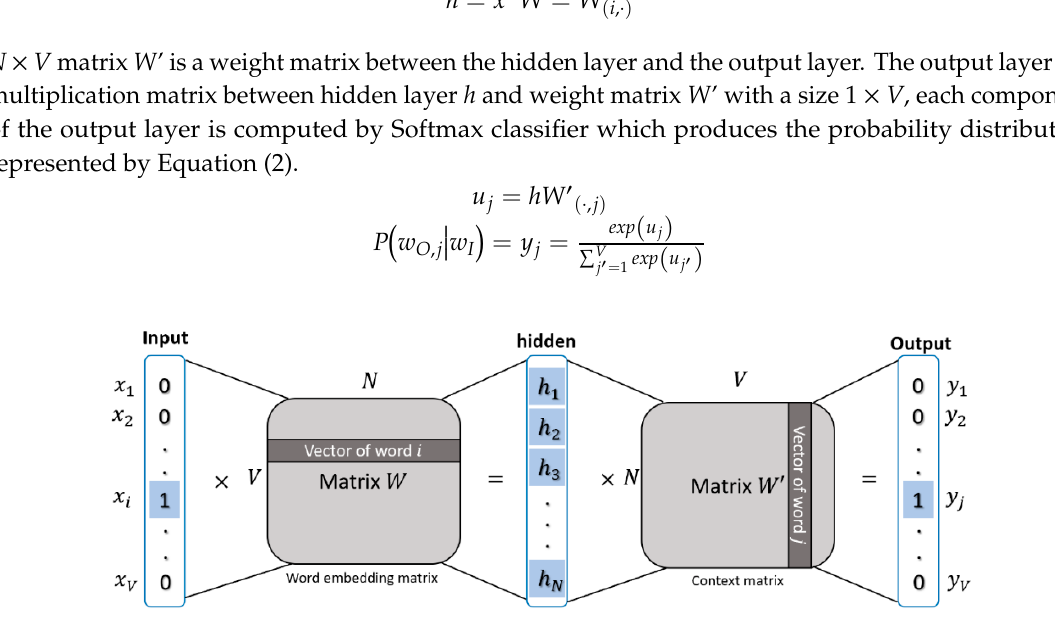
Figure 1. Word2vec with a skip-gram model which is one hidden layer artificial neural network.